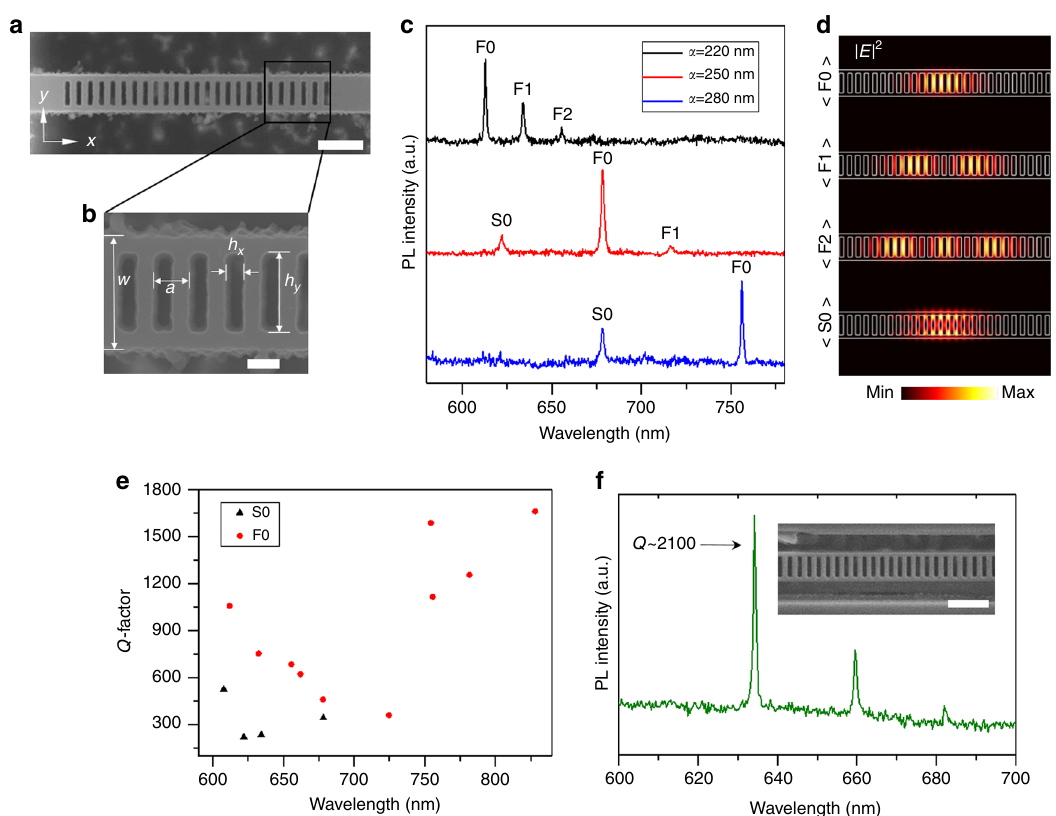
Fig. 2 Optical analysis of one dimensional (1D) hBN photonic crystal cavities. a SEM image of a 1D ladder PCC with 25 rectangular air holes. The scale bar is 1 µ m. b magni fi ed view showing the geometrical parameters; width ( w ), lattice constant ( a ), air hole width ( h x ) and air hole height ( h y ). The cavity was fabricated using a combination of RIE and EBIE. The scale bar corresponds to 200 nm. c Photoluminescence spectra of different 1D ladder PCCs in the same hBN crystal with varying lattice constants of 220 nm (black), 250 nm (red), and 280 nm (blue), respectively. F0, F1, and F2 mark the position of the zeroth, fi rst, and second order mode from the fi rst dielectric band. S0 marks the position of the zeroth order from the second dielectric band mode. d 3D FDTD simulation result showing fi eld pro fi les of the measured optical modes. e Experimentally obtained Q -factors of various 1D PCCs fabricated from hBN. f PL spectrum of a 1D cavity fabricated by focused ion beam milling, showing a high Q (~ 2100) mode in the visible spectral range. The inset is an SEM image of the cavity and the scale bar corresponds to 1 µ